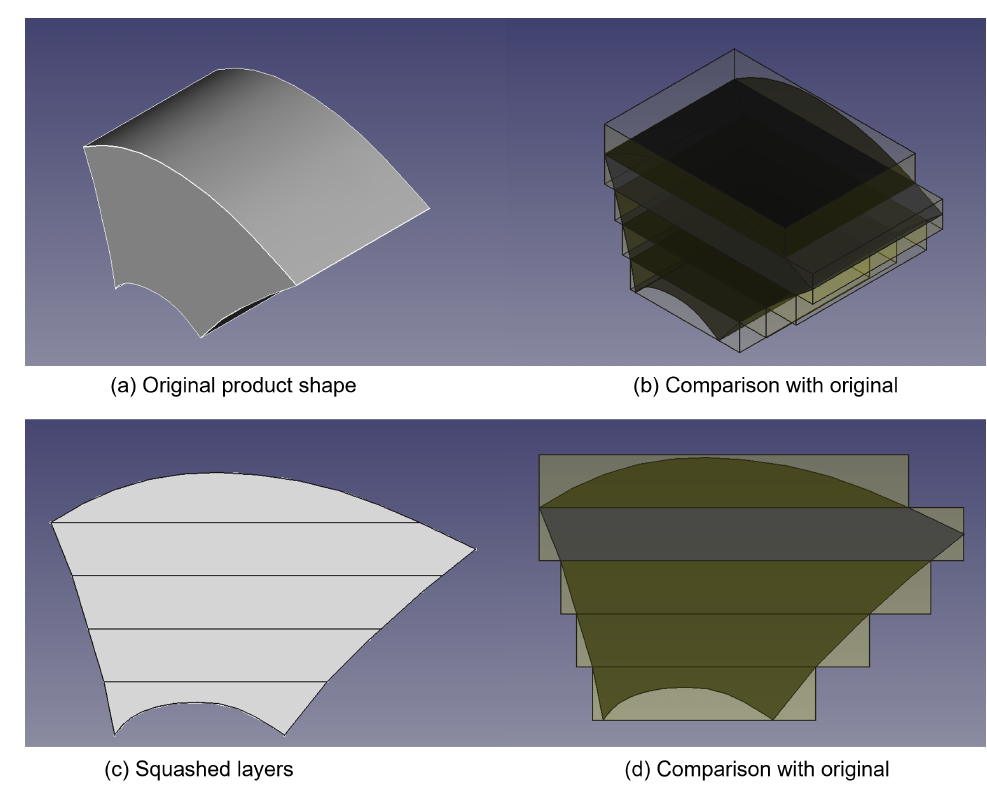
Figure 15. A result of squashing operation with planar direction: ( a ) CAD file to be produced, ( b ) Transparent slices made by the proposed squashing algorithm, ( c ) The product shape split by slice boundaries, and ( d ) side of slice layer and the product